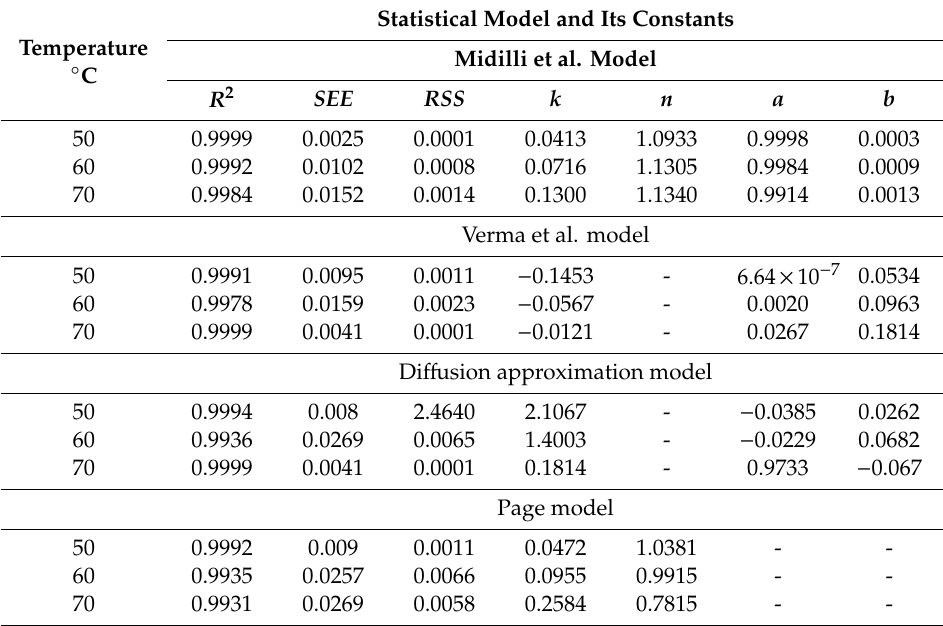
Table 4. Statistical models and its constant values for the thin layer drying models. Statistical Model and Its Constants Temperature Midilli et al. ◦ C